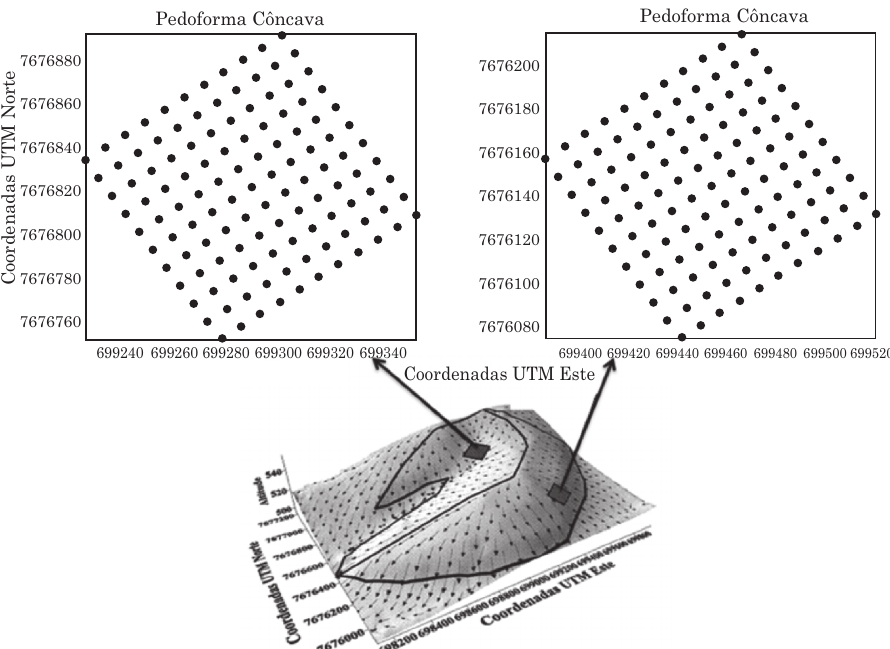
Figura 1. Localização da área de estudo e pontos de amostragem ( (cid:122)(cid:122)(cid:122)(cid:122)(cid:122) ) em malha regular. Adaptado de Camargo et al.